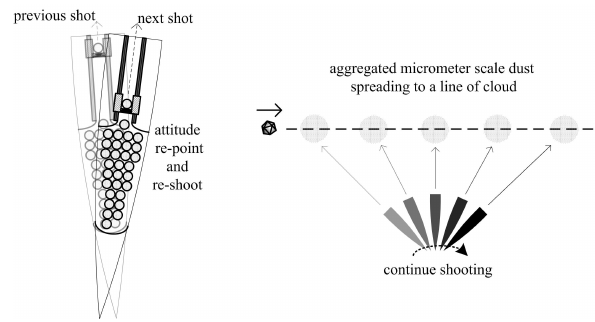
Figure 9. Shooting of MSD to form a line of clouds